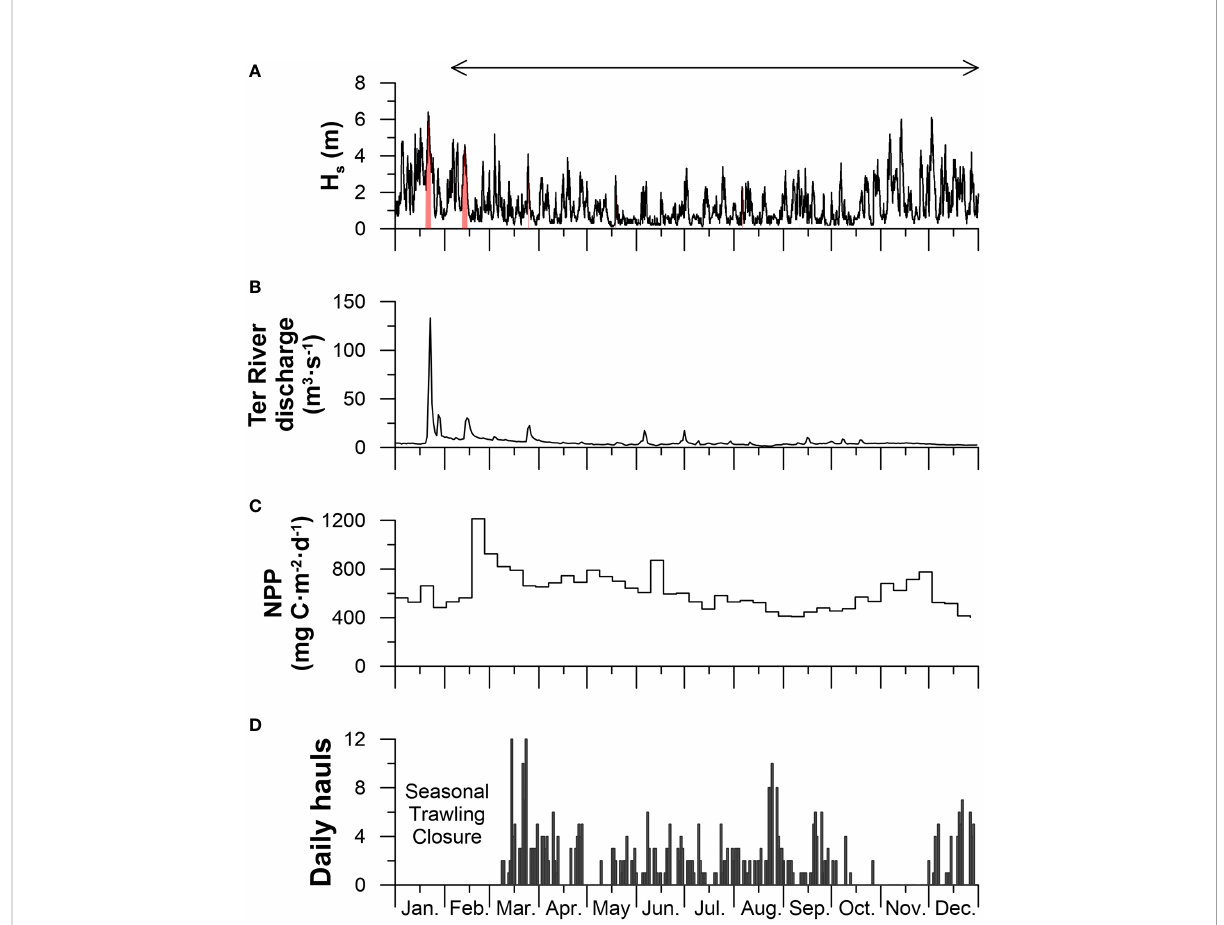
FIGURE 2 Forcing conditions in 2017. (A) Signi fi cant wave height (H s ) measured at the Cap de Begur buoy, where eastern storms are identi fi ed in red. (B) Ter River discharge. (C) 8-day average net primary productivity (NPP). (D) Daily hauls in the trawling ground above the Montgr ı ́ tributary gully (see yellow polygon in Figure 1). The horizontal arrow on top indicates the monitoring